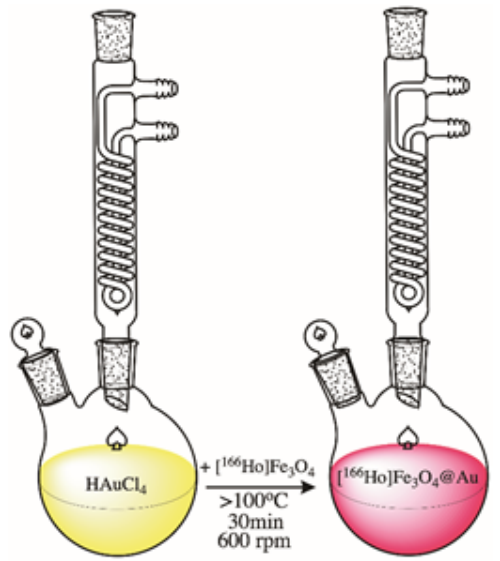
Figure 2. Schematic image of [ 166 Ho]Fe 3 O 4 coating with Au.